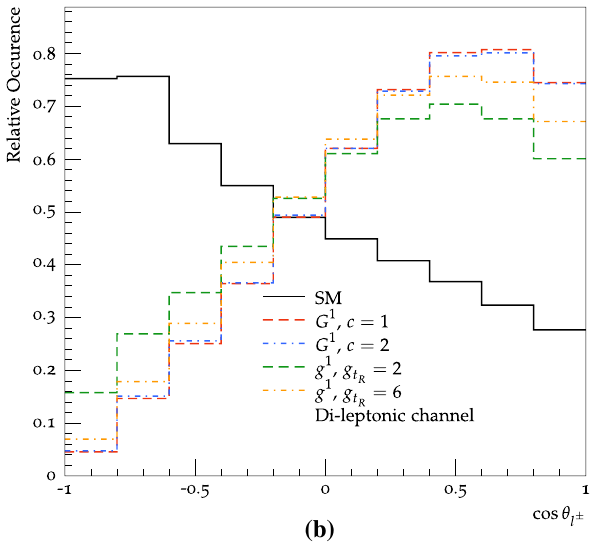
angledistributionswhencomparedtotheSMexpectationwhichatthese high invariant masses is slightly left-handed. Note that the